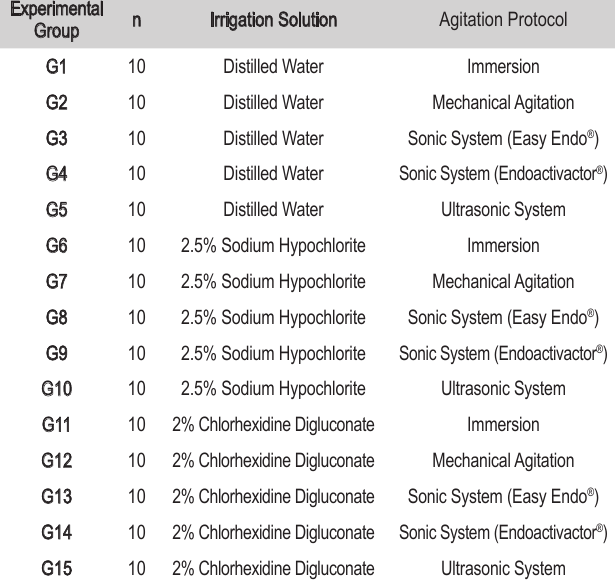
Table 1 - Experimental groups.